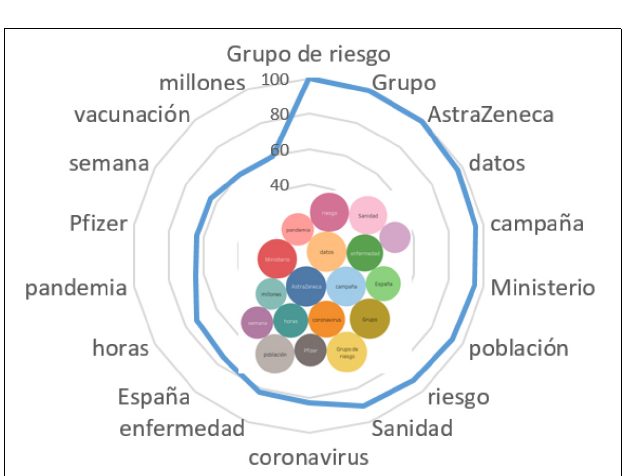
FIGURE 3 | Associative network of the stimulus risk group/ Grupo de